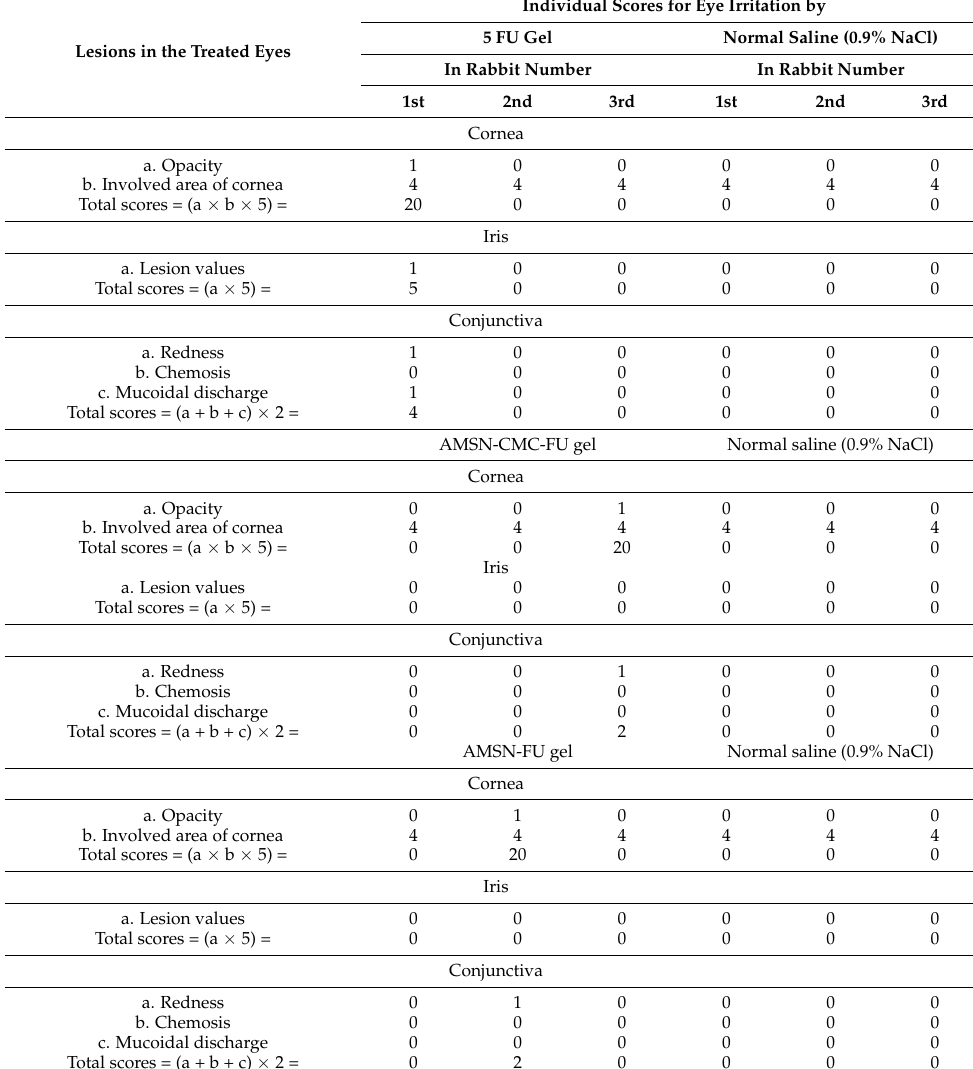
Table 4. Weighted scores for the eye irritation test of 5 FU-containing formulations. Individual Scores for Eye Irritation by 5 FU Gel Normal Saline (0.9% Lesions in the Treated Eyes